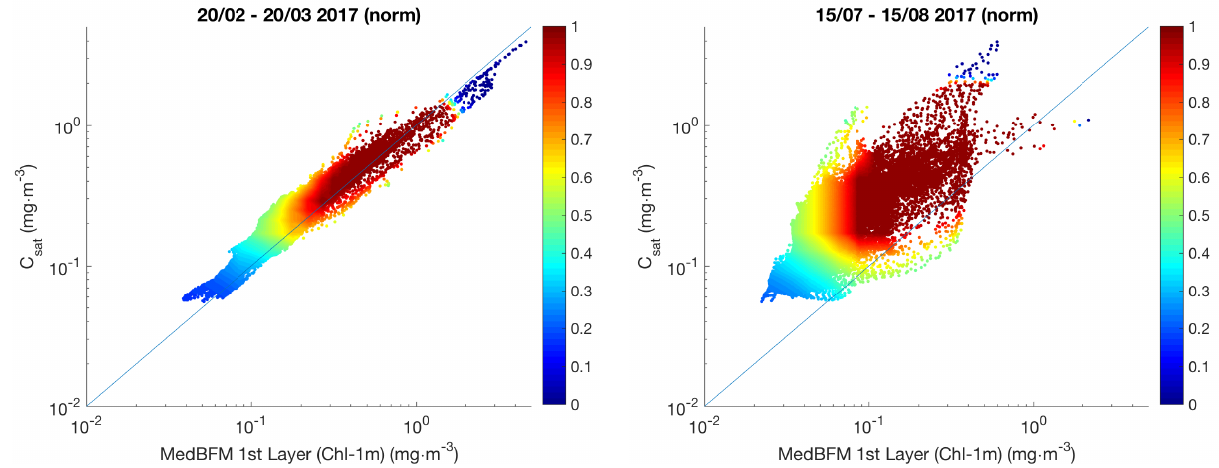
Figure 1. ( Left ) Normalized scatter density plots between Chl-1m and C sat . ( Left ) high biological production period, 20 February to 20 March 2017. ( Right ) low biological production period, 15 July to 15 August 2017. In both panels, the identity line is given in